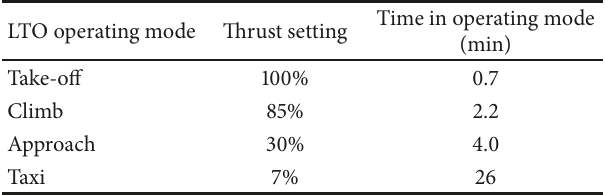
Table 3: Reference emissions LTO